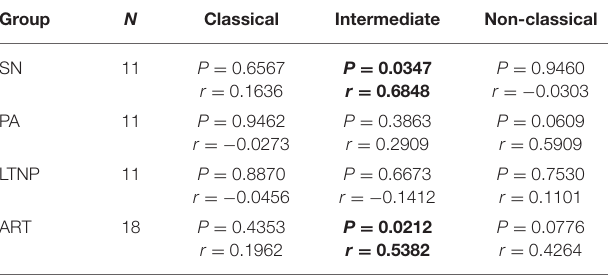
TABLE 2 | Association of CD206 with HLA-DR expression on monocytes